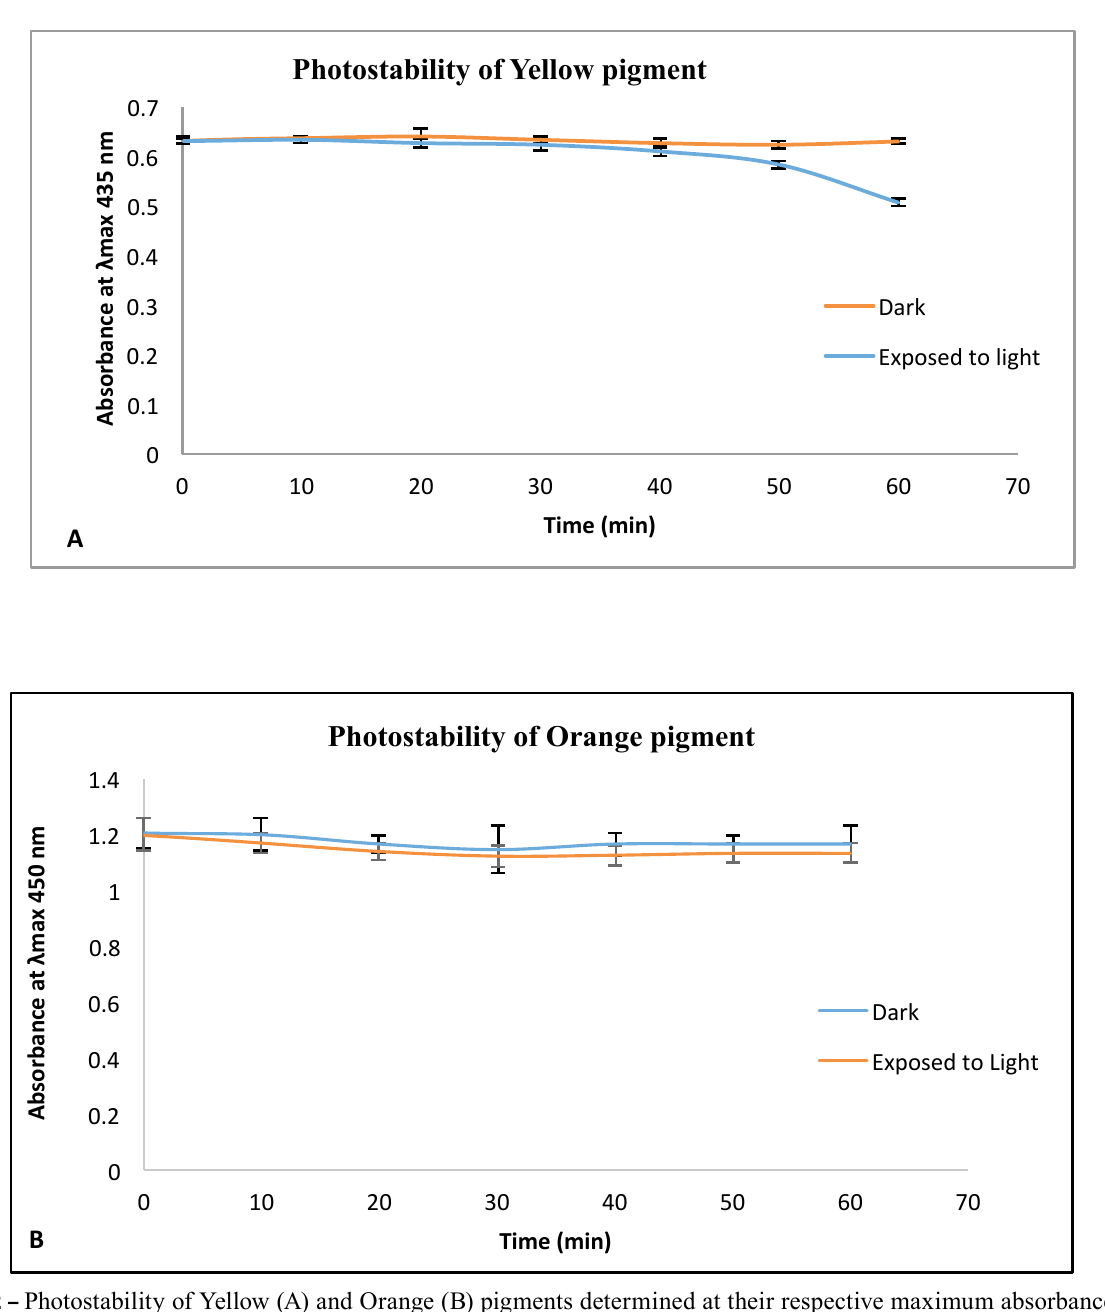
FIGURE 2 – Photostability of Yellow (A) and Orange (B) pigments determined at their respective maximum absorbance peaks (435 nm- yellow and 450 nm-Orange). Each plotted point represents three trials expressed as mean ±